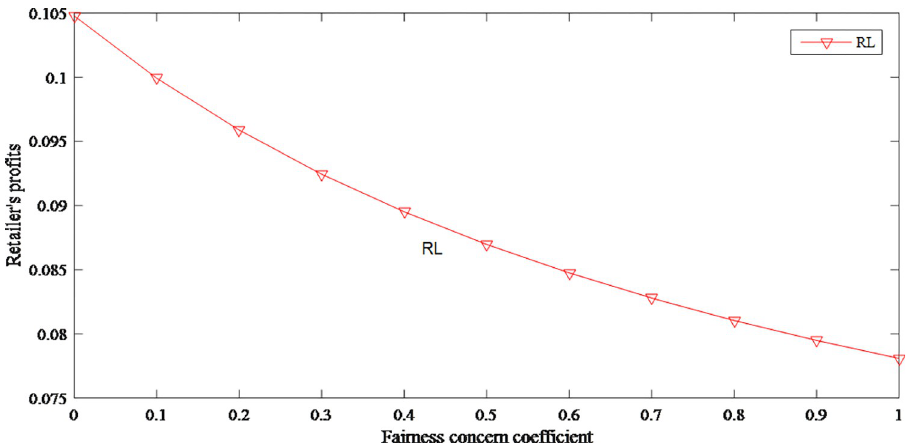
Fig 12. The impact of fairness concerns on retailer’s profits.